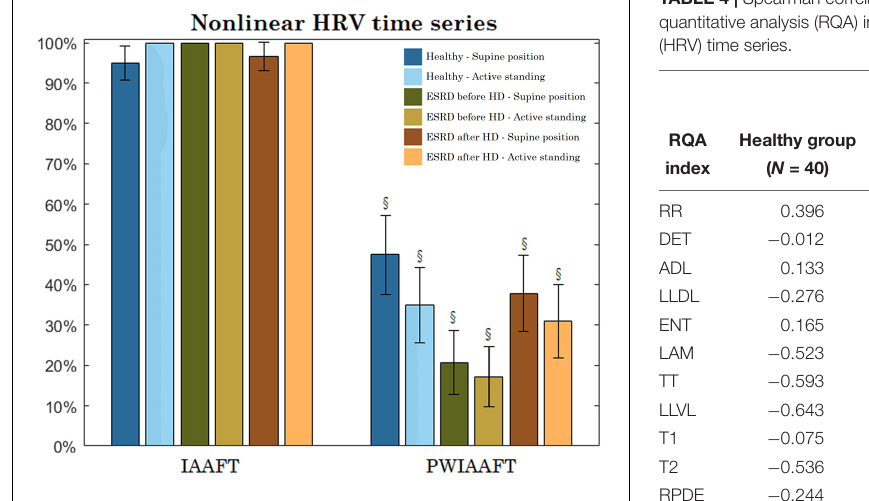
FIGURE 8 | Percentage of heart rate variability (HRV) time series of every group that leads to reject the null hypothesis (nonlinearity demonstrated) using Iterative Amplitude Adjusted Fourier Transform (IAAFT) and Pinned Wavelet Iterative Amplitude Adjusted Fourier Transform (PWIAAFT) techniques (bars display the 95% confidence interval). § PWIAAFT vs IAAFT in the same group p < 0.001. There were no significant differences between groups (same position) nor within groups (supine vs active standing, same group).